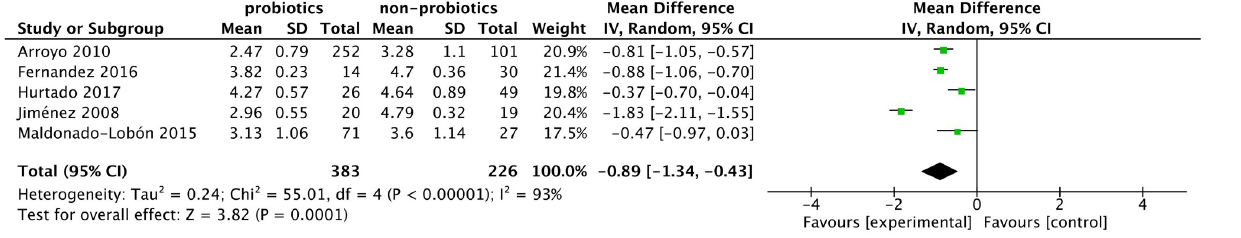
Fig 6. Forest plot of bacterial counts in patients with lactational mastitis.